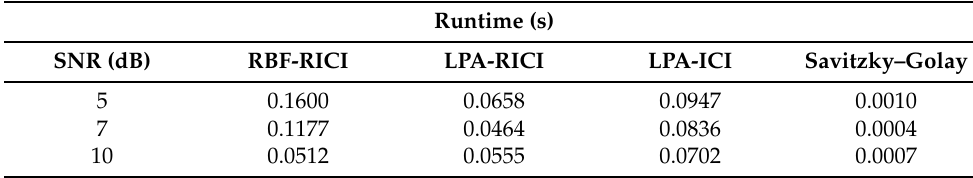
Table 21. Doppler signal—Filtering algorithms’